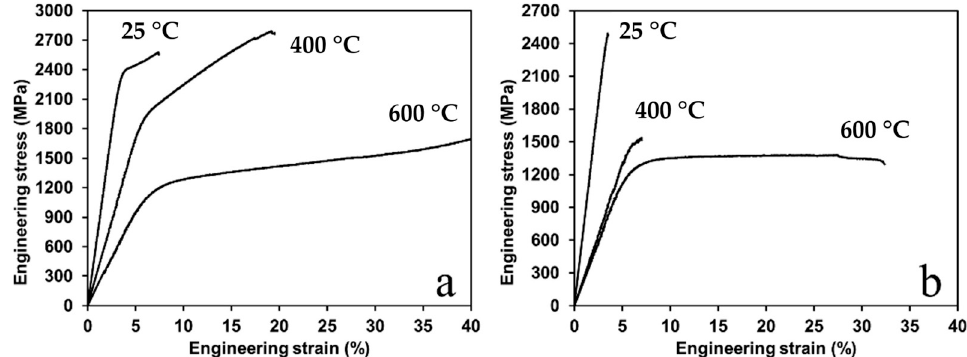
Figure 7. Stress–strain curves obtained during the compression tests of the Al 3.5 Cr 3.5 NiFeCr alloy after RSPS ( a ) and CS+SPS ( b ). Table 5. Mechanical properties of Al 3.5 Co 3.5 NiFeCr alloy sintered at 1000 °C.